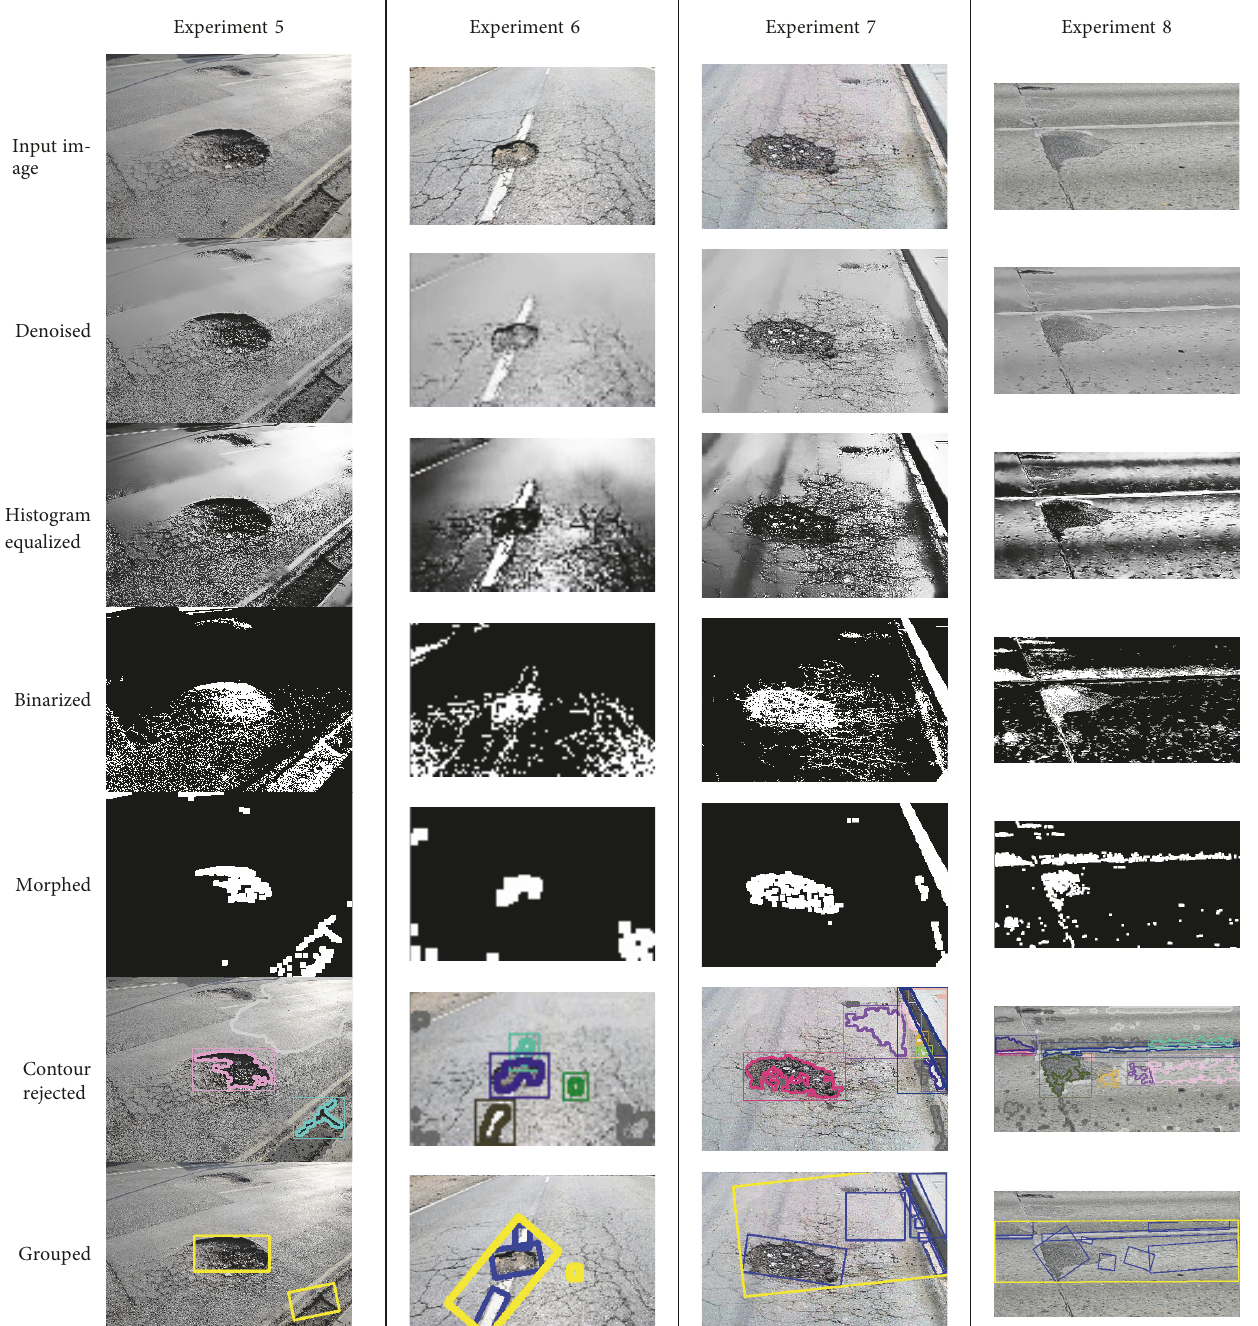
Figure 5: Results of the 5th–8th experiments . Pothole road distress detection and grouping based on 2D image analysis (sources of all input images are concluded in Table